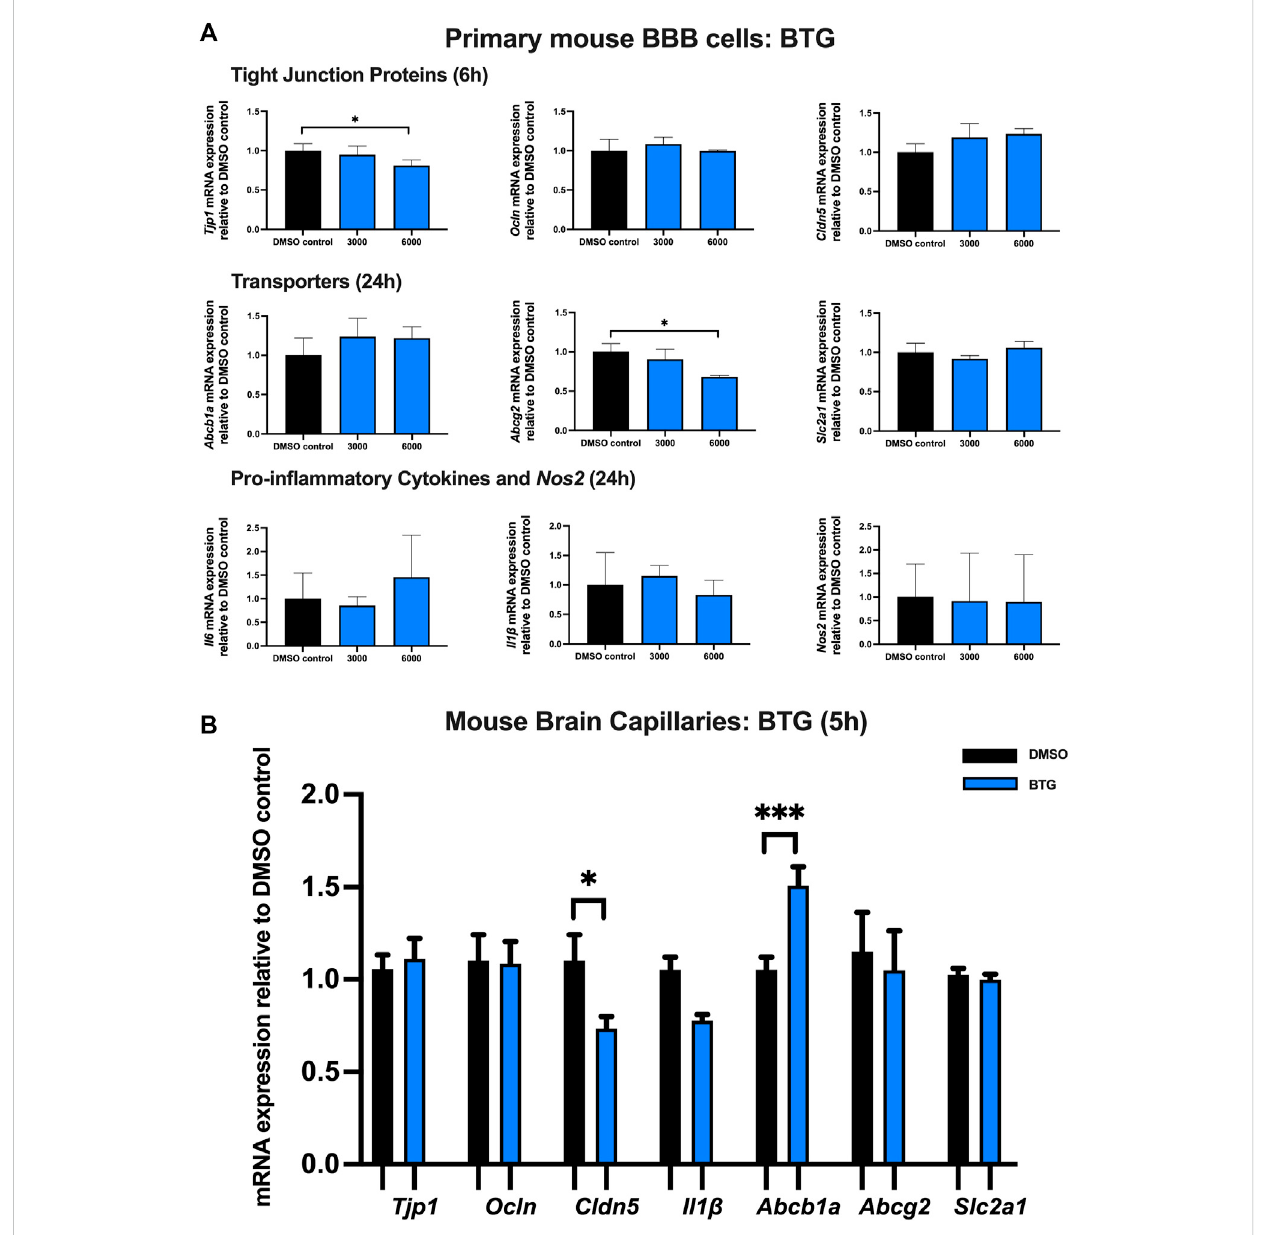
FIGURE 6 mRNA expression of TJ proteins, transporters, proin fl ammatory cytokines and Nos2 in primary cultures of mouse brain microvascular endothelial cells exposed to BTG (3,000, 6,000 ng/mL) and vehicle (DMSO) control for 6 or 24 h and in isolated mouse brain capillaries exposed to BTG (6,000 ng/ mL) and vehicle (DMSO) control for 5 h (A) mRNA expression of Tjp1, Ocln, Cldn5, Abcb1a, Abcg2, Slc2a1, Il6, Il1 β and Nos2 in primary cultures of mouse brain microvascular endothelial cells exposed to BTG relative to vehicle (DMSO) control was assessed by qPCR. Results are presented as mean relative mRNA expression ±SEM normalized to the housekeeping mouse cyclophilin B gene from n = 4 independent experiments. (B) mRNA expression of Tjp1, Ocln, Cldn5, Abcb1a, Abcg2, Slc2a1 and Il1 β in isolated mouse brain capillaries treated for 5 h with BTG (6,000 ng/mL) relative to vehicle (DMSO) was assessed by qPCR. Results are presented as mean relative mRNA expression ±SEM normalized to the housekeeping mouse cyclophilin B gene from n = 3 independent experiments, where each experiment contained pooled brain tissues from 6 animals per group. One-way ANOVA with Bonferroni ’ s post-hoc test (A) , unpaired two-tailed Student ’ s t -test (B) : *, p < 0.05; ***, p <